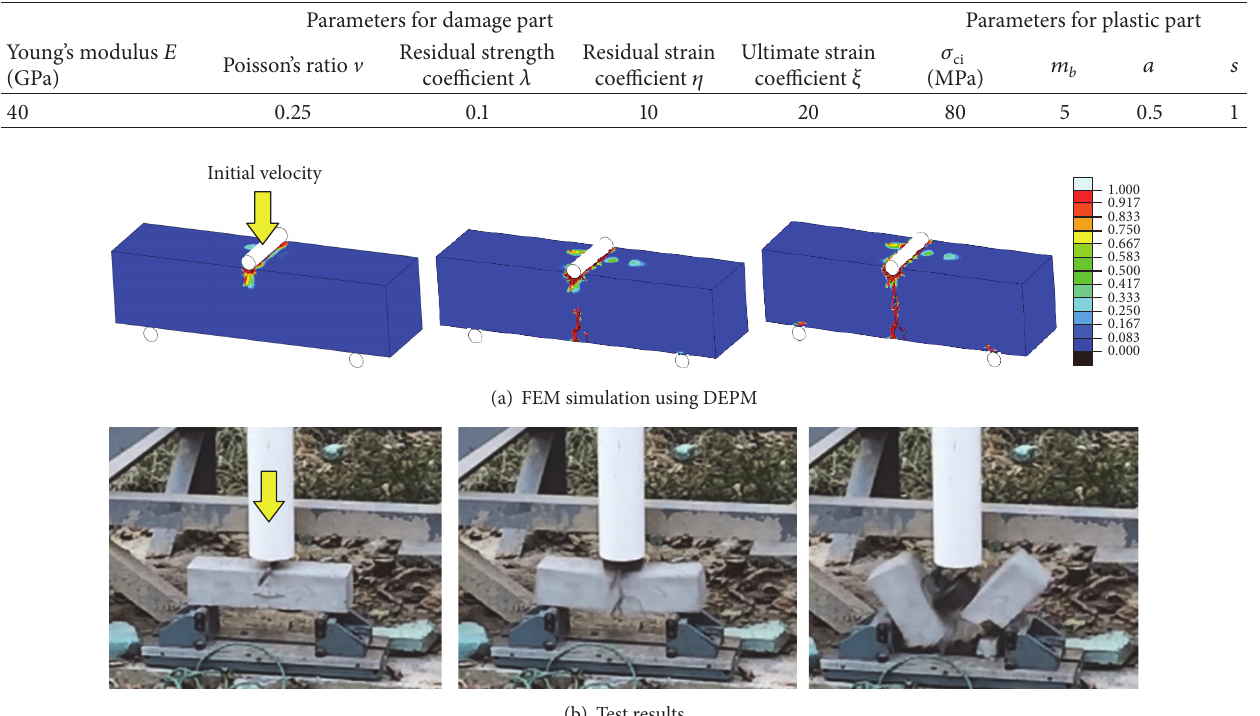
Figure 3: Concrete beam fracture due to impact